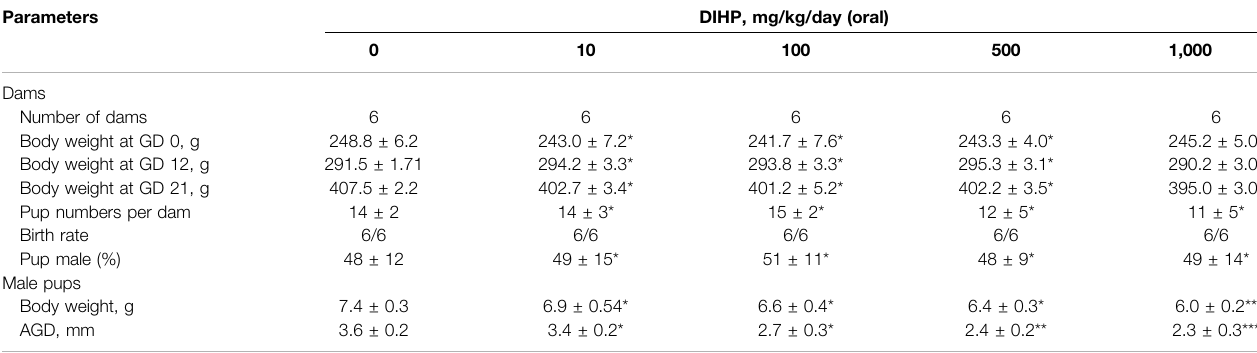
TABLE 1 | Toxicological parameters before and after exposure to diisoheptyl phthalate (DIHP).